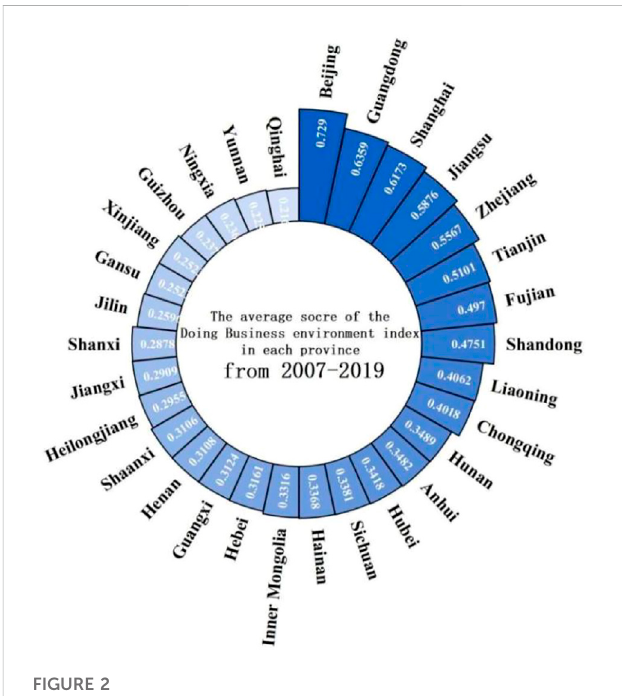
FIGURE 2 The average score of each province from 2007 to 2020.